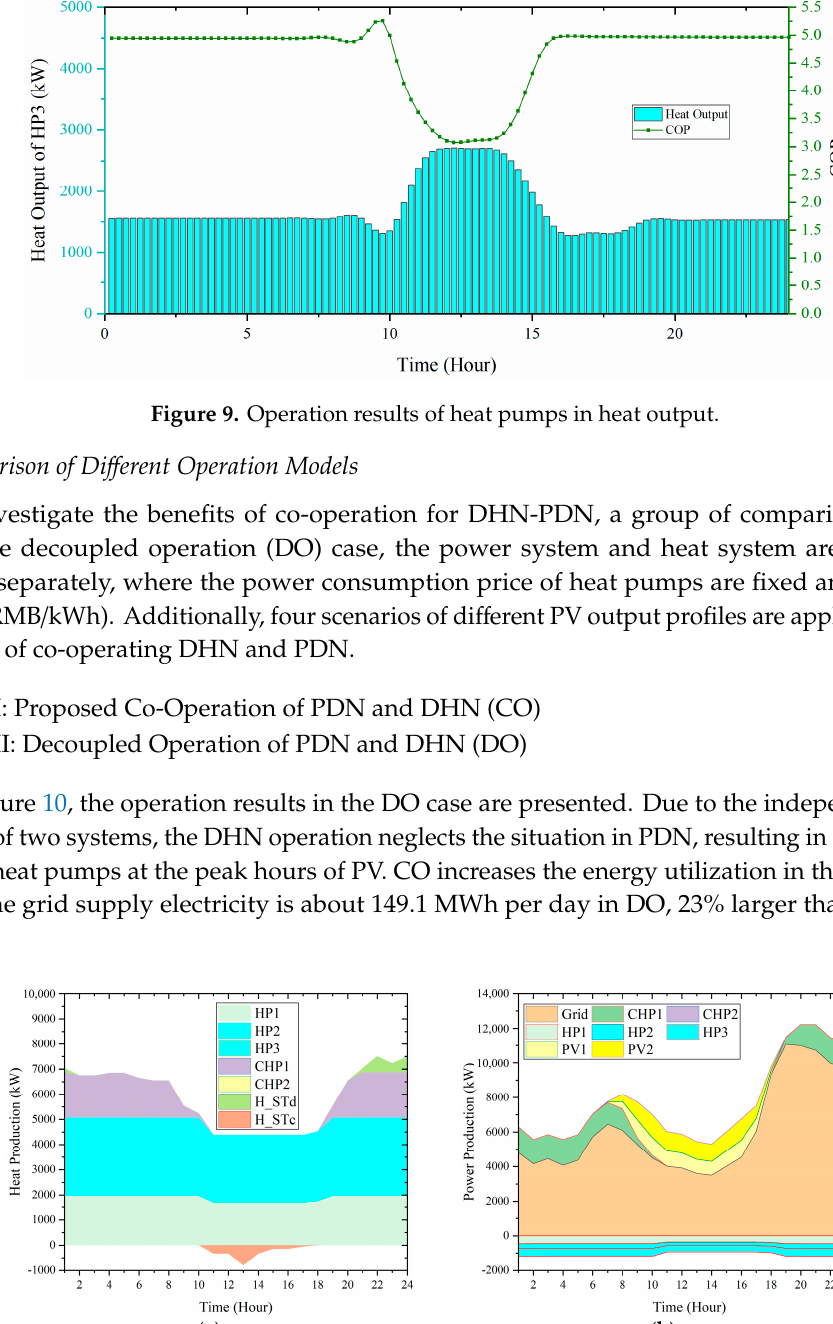
Figure 10. Decoupled Operation results of ( a ) DHN ( b ) PDN.